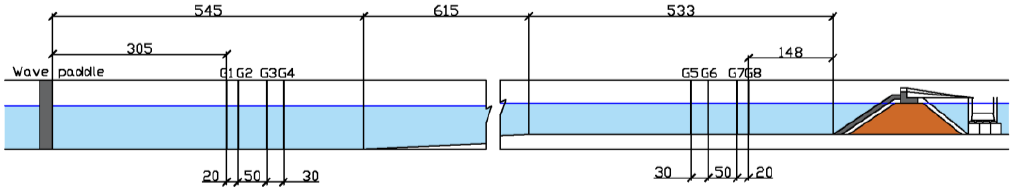
Figure 4. Longitudinal cross-section of the wave flume of the Laboratory of Ports and Coasts at the Universitat Politècnica de València (LPC-UPV). Dimensions presented in cm.